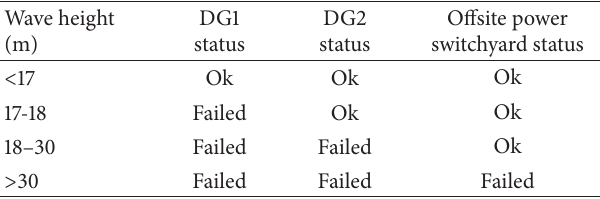
Figure 17: Max flooding levels for several wave heights. Table 4: Status of the two DGs (DG1 and DG2) and the PG switchyard as a function of the wave height using the NEUTRINO simulation code.